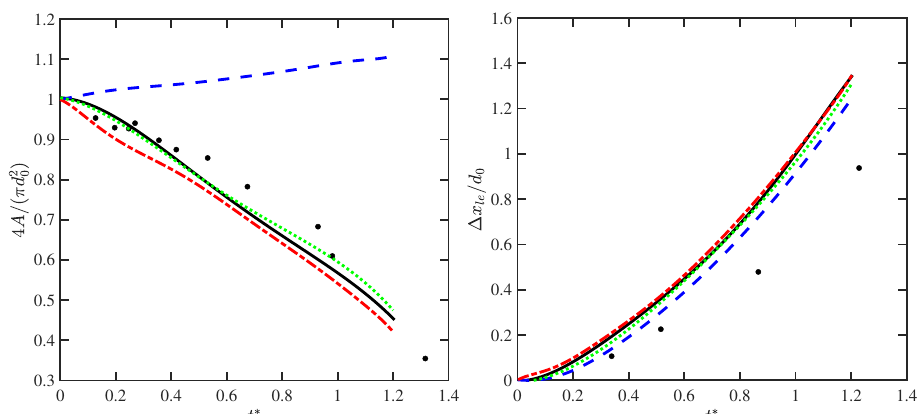
Figure 7. Time history of the normalized cross-section area ( left ) and leading-edge drift ( right ) of the water column: CFD II (green dotted line) and CFD III (black solid line), compared to reference numerical solutions (blue dashed and red dashed-dotted lines) and experimental data